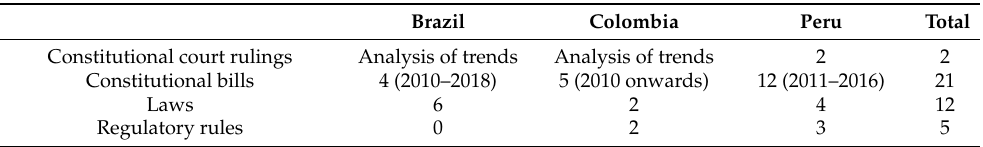
Table 1. Summary of the materials